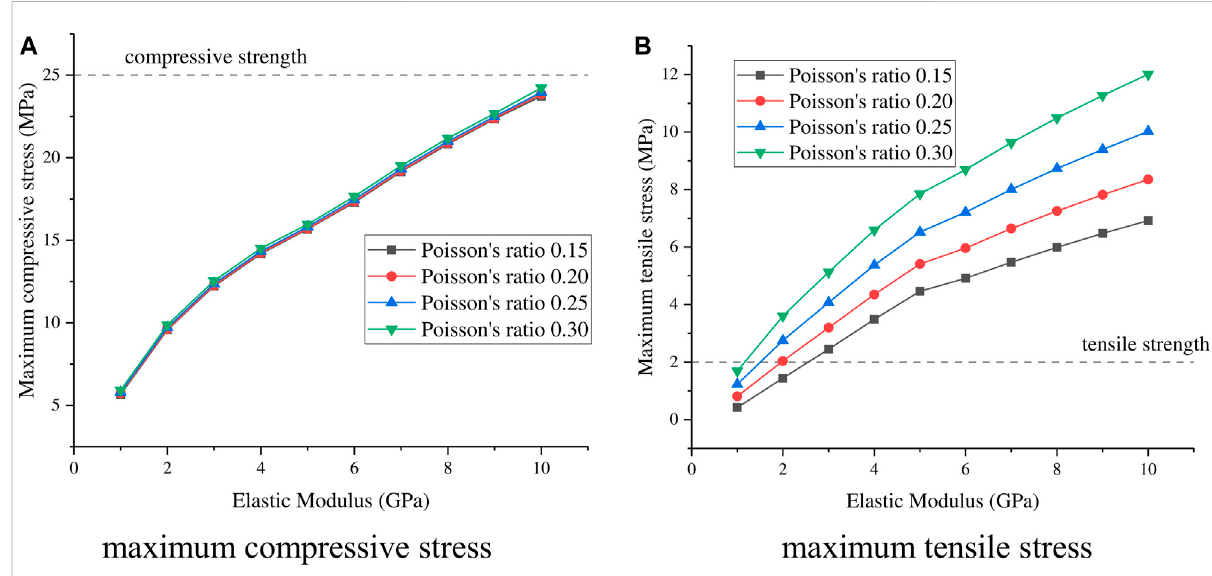
FIGURE 11 The in fl uence of the elastic parameters of cement sheath on its maximum compressive stress and maximum tensile stress. (A) Maximum compressive stress. (B) Maximum tensile stress.